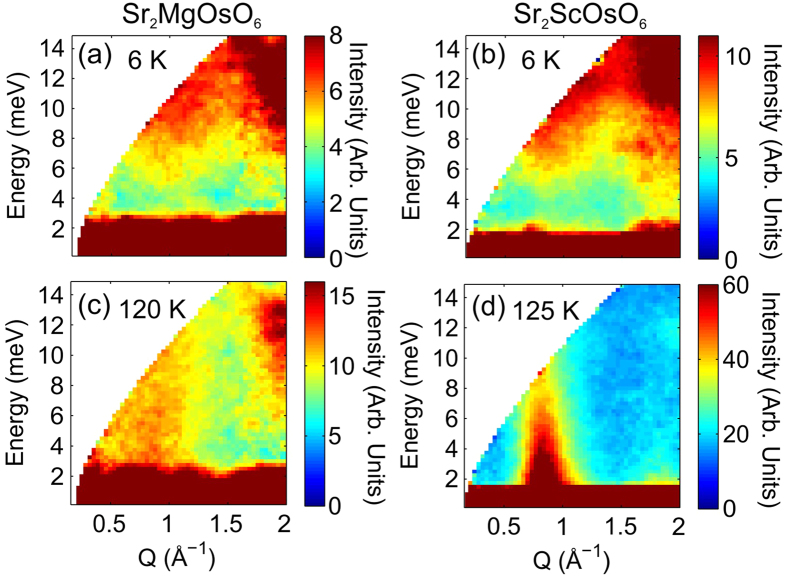
Neutron scattering intensity maps, measured with Ei = 20 meV, showing the gap below TN for (a) Sr2MgOsO6 and (b) Sr2ScOsO6 which closes above TN in (c,d) respectively.